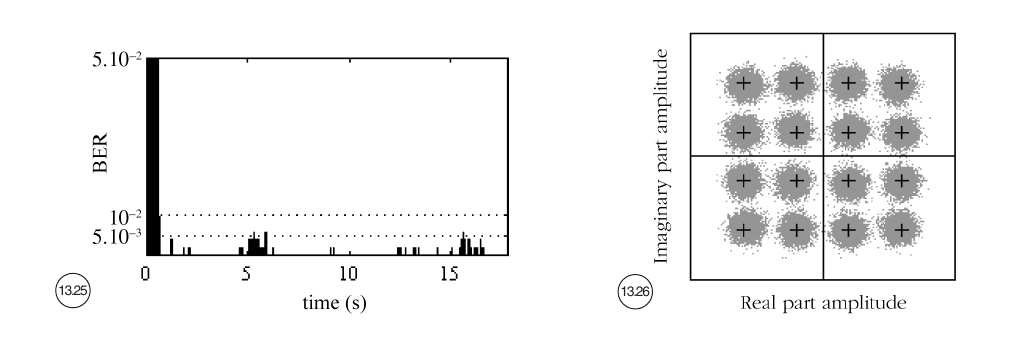
Fig. 13.25. Temporal variations of the BER. Fig. 13.26. Constellation at the output of the spatial filter.